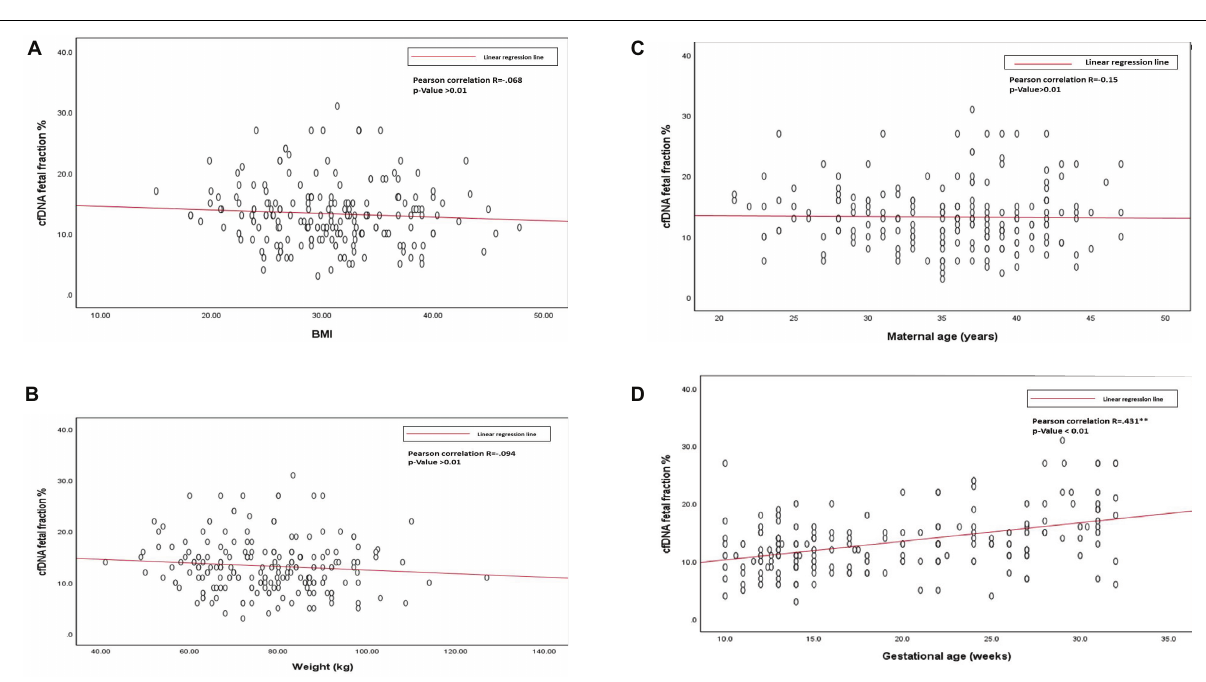
Descriptive data analysis was presented by mean values and standard deviations, while categorized data were compared by percentage. Correlation analysis were also used, and the Pearson value was calculated (significant if ≤